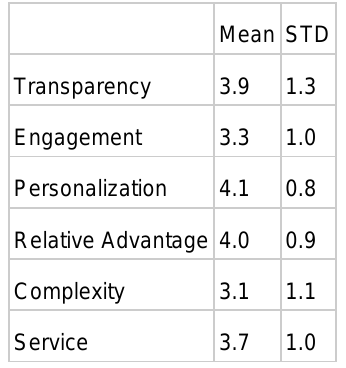
Table 4 . Average score of each standalone variable